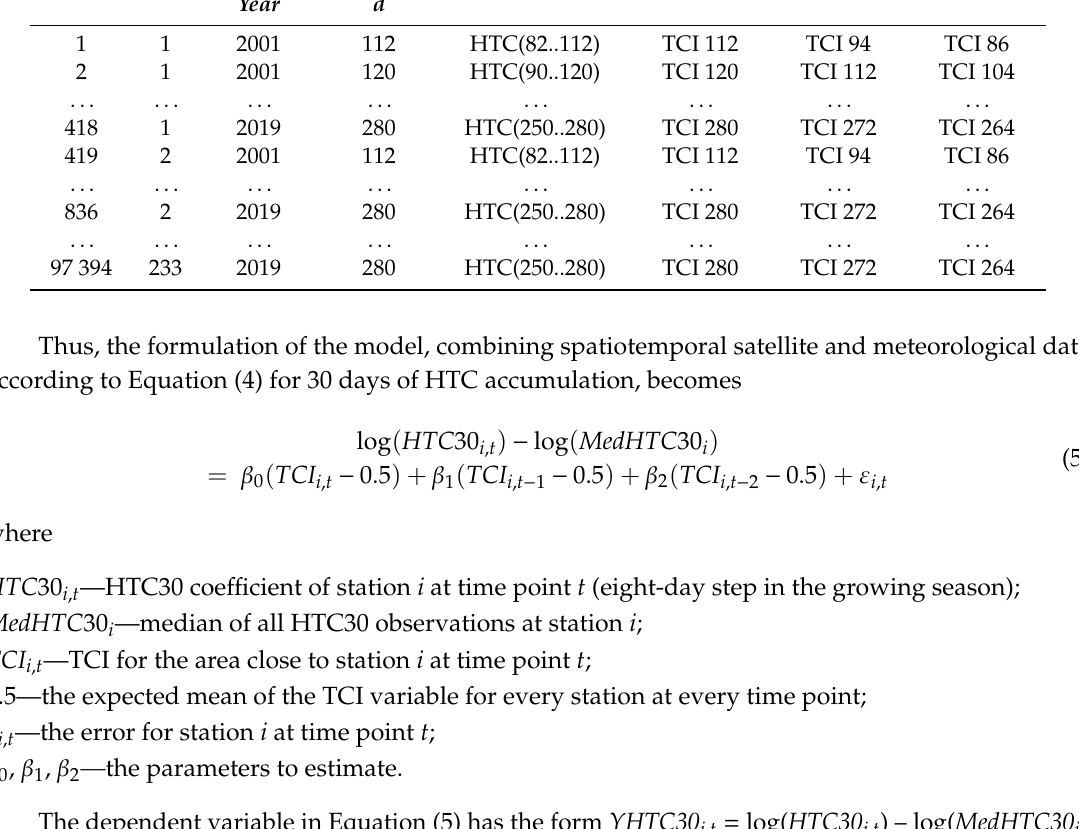
Table 1. Example of panel data for the fusion of meteorological and satellite indices.